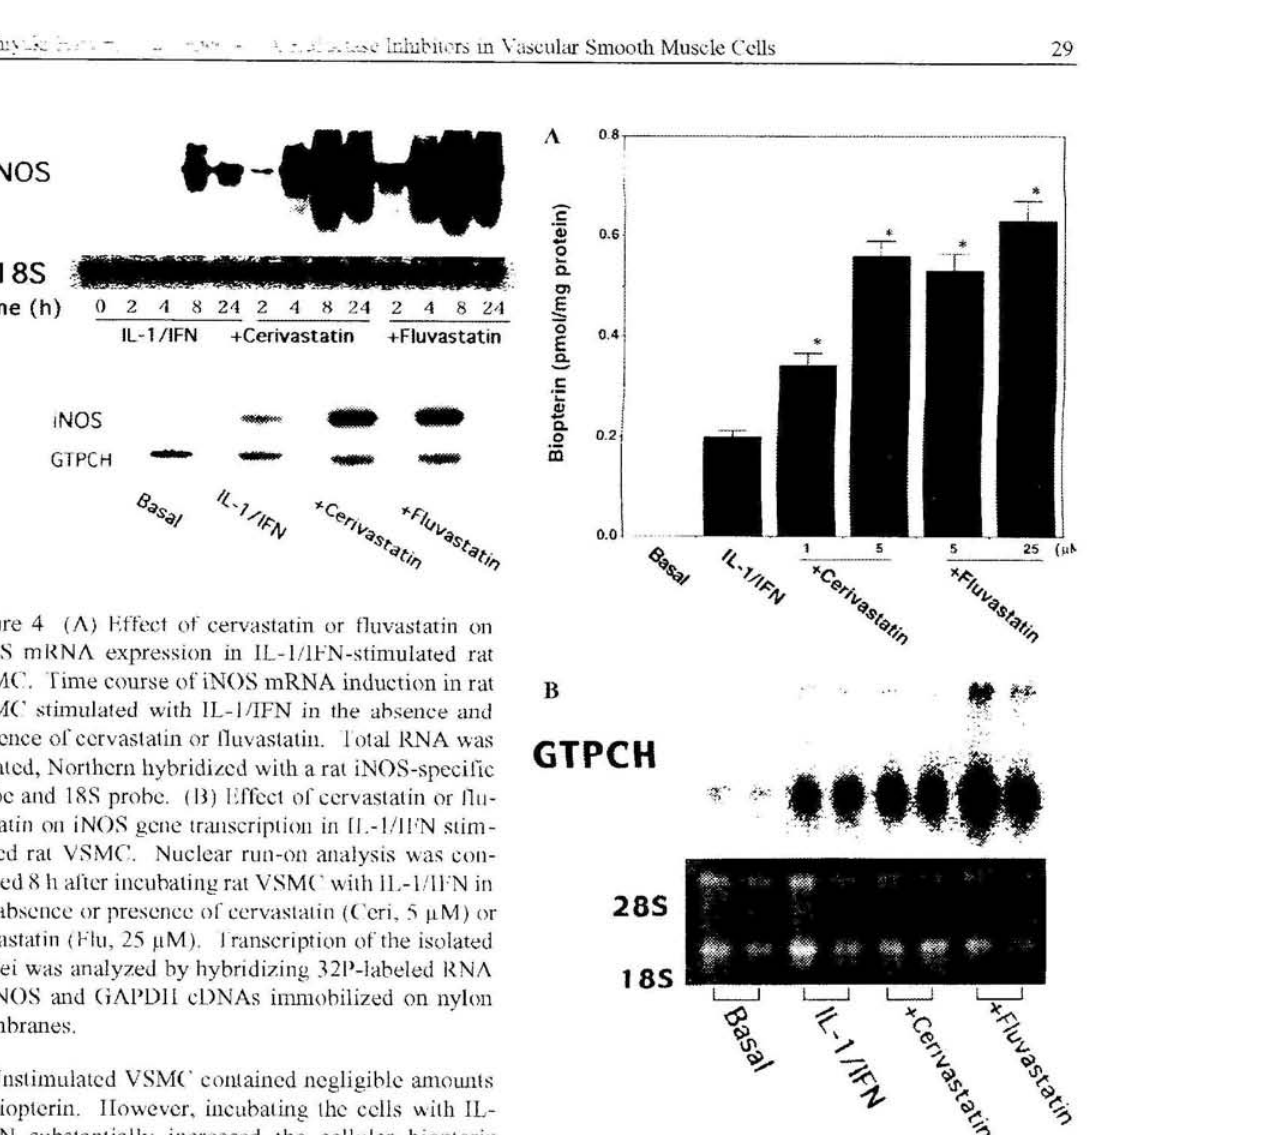
Figure 5 (A) Effect of cervastatin or lluvastatin on cel- lular biopterin contents in 1I.-1 IFN-stimulated